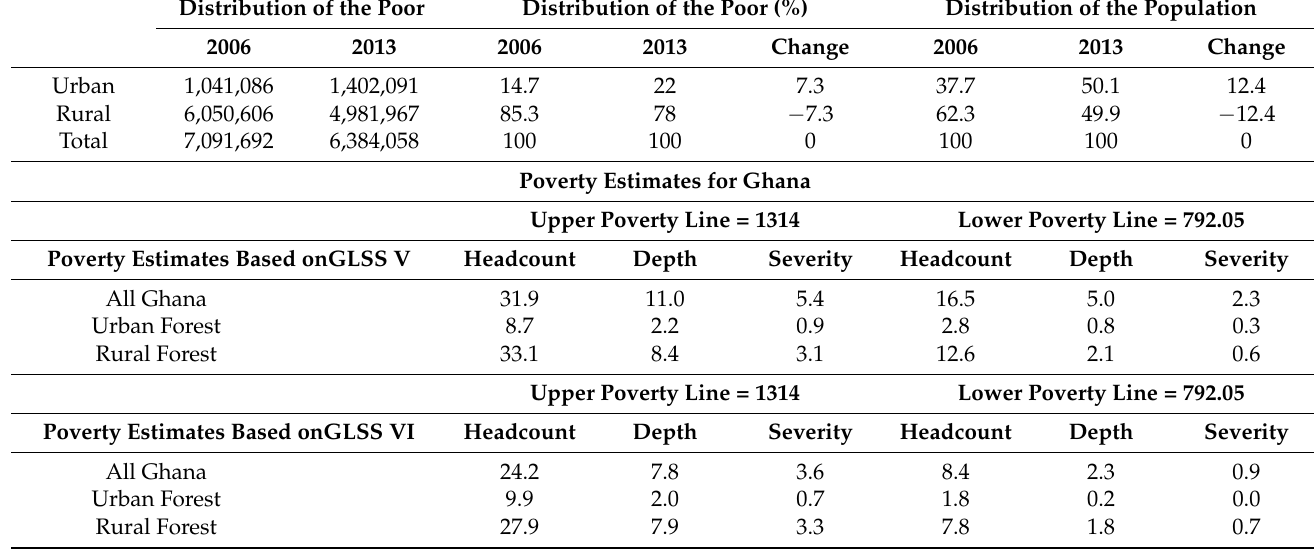
Table 5. Distribution of the poor and the population (2006 and 2013) and poverty estimates for Ghana. Distribution of the Poor Distribution of the Poor (%) Distribution of the Population 2006 2013 2006 2013 Change 2006 2013 Change